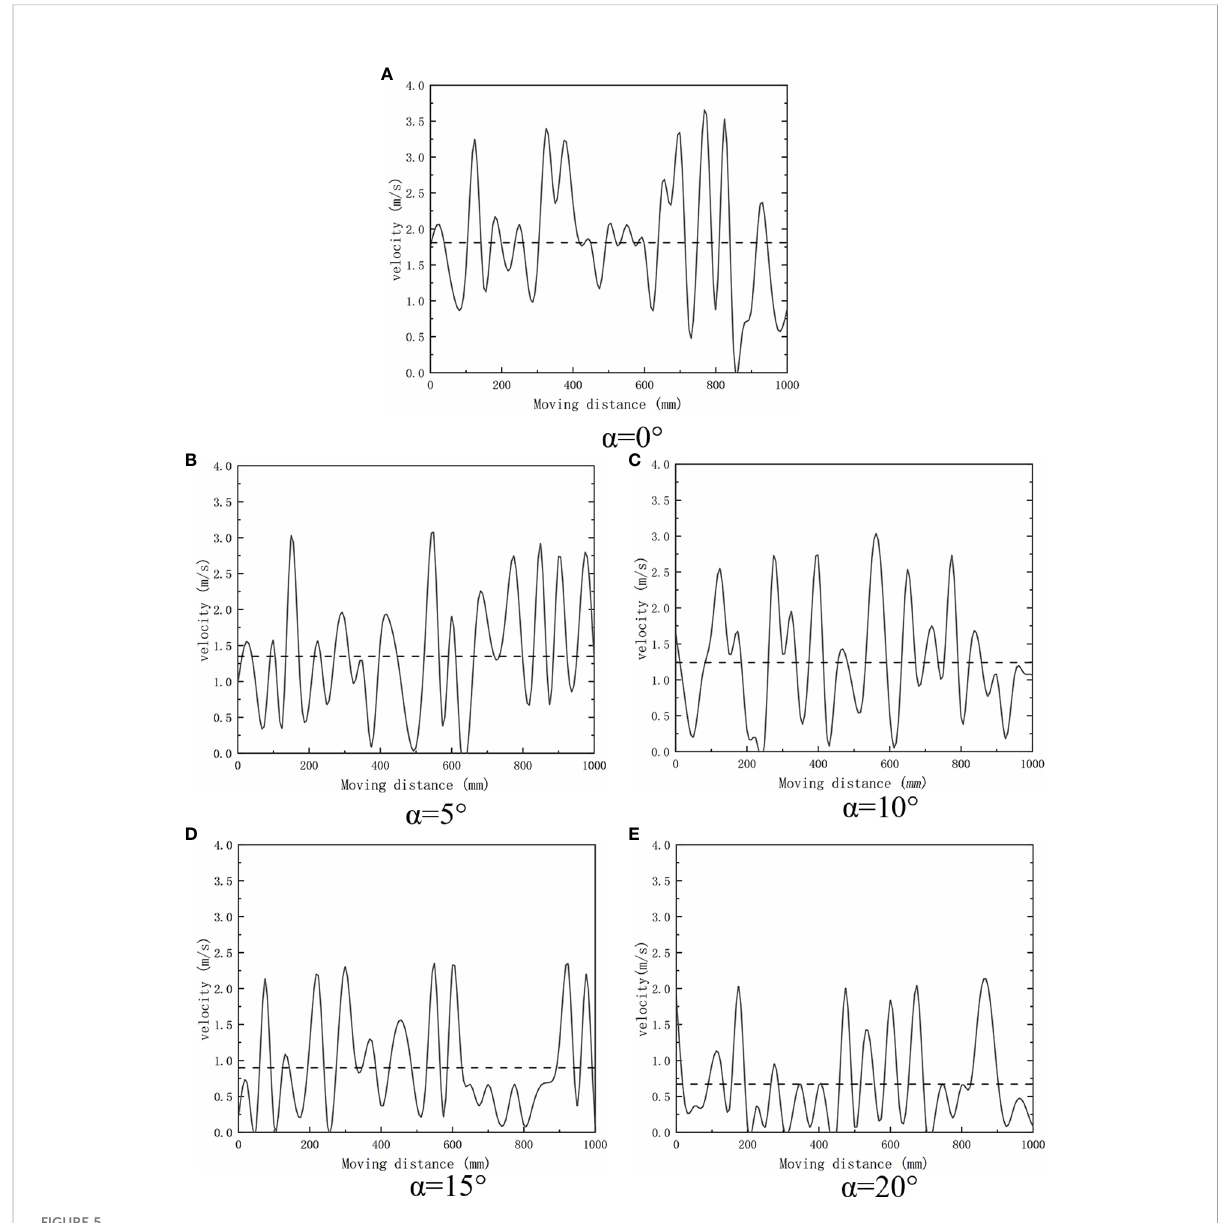
FIGURE 5 Velocity map of soil particles at fi ve installation